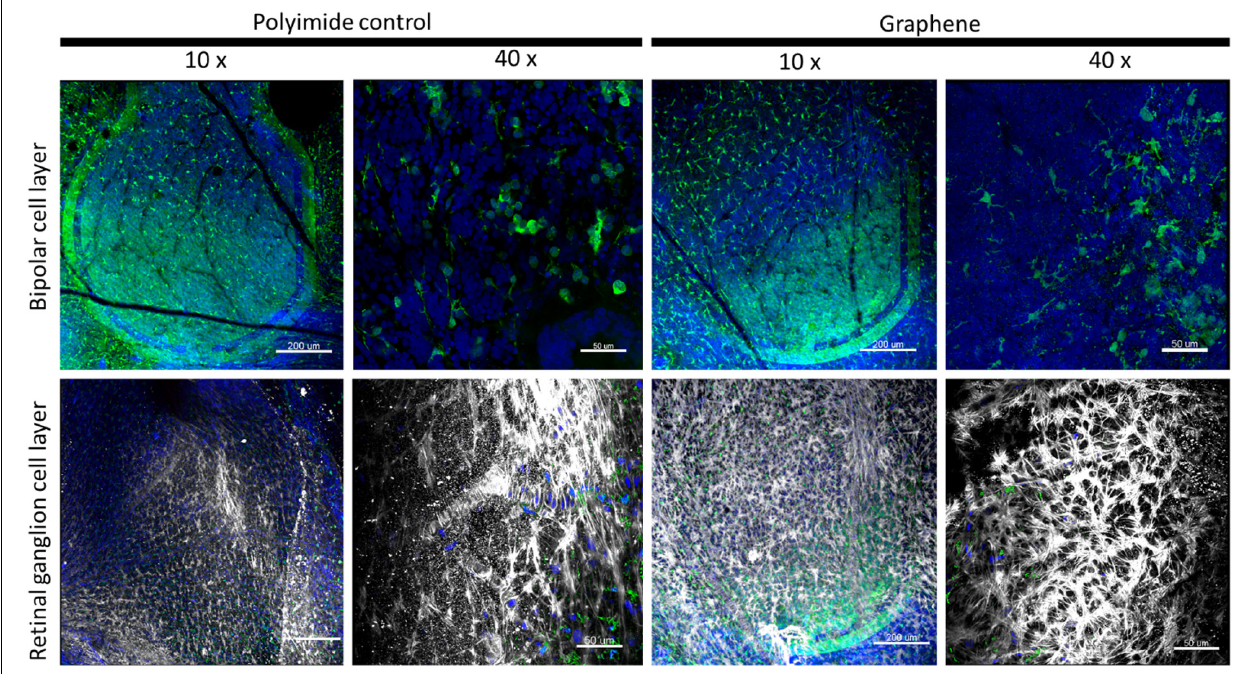
FIGURE 4 | Low (10x) and high (40x) magnifications of retinal tissues at the graphene and polyimide implant interface. Images show the different immunolabeled cells: green Iba1-positive microglia, and white GFAP-positive Müller and astrocyte cells with blue DAPI-stained nuclei. Note the green autofluorescent polyimide ring of the implants at the 10x magnification in the bipolar layer of the polyimide control and at both layer for the graphene implant. Scale bars are 50 µ m (10x) and 200 µ m